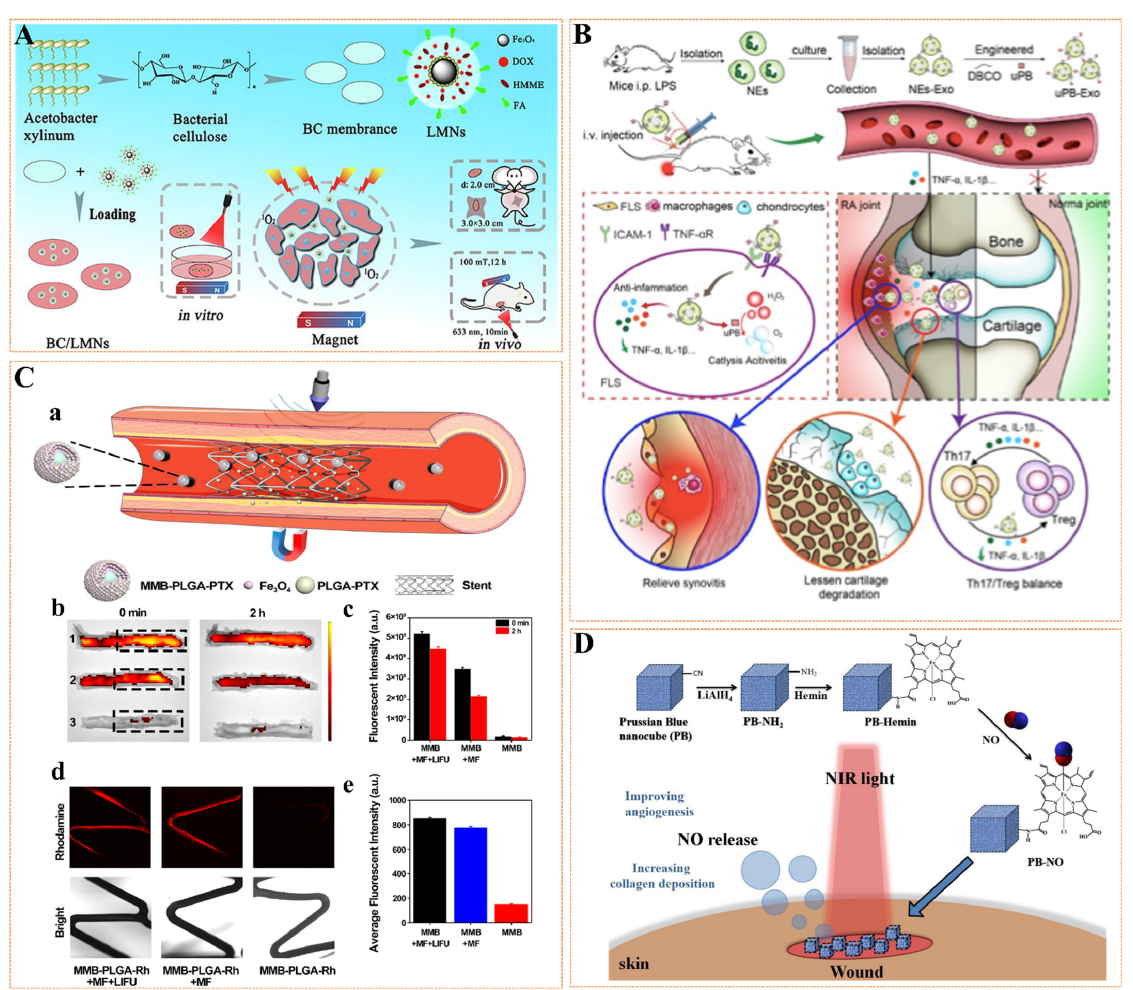
Figure 5. ( A ) The laser-sensitized magnetic nanoparticles (LMN) were constructed using Fe 3 O 4 na- noparticles as the core, coated with doxorubicin and hematoporphyrin mether hydrogel, and then coated with dendritic acid on the surface of the composite. LMN was then loaded into the bacterial cellulose (BC) membrane. Synthetic BC/LMN enhances transdermal drug targeting for breast cancer when administered via magnetic field and laser. Reprinted with permission from Ref. [109]. Copy- right 2019, copyright Zhang L.K. et al. (B) Surface-engineered neutrophil-derived exosomes (NEs- Exo) and ultra-small Prussian blue magnetic nanoparticles (uPB) effectively treat advanced rheu- matoid arthritis by clicking on the chemically mediated repair of the inflammatory environment. Reprinted with permission from Ref. [110]. Copyright 2022, copyright Zhang L. et al. ( C ) Schematic diagram of magnetic guided and ultrasonic stimulation for the treatment of ISR with targeted and deep penetrating delivery strategies ( a ); Evaluation of MMB-PLGA Rhdomain targeting and pene- tration of isolated porcine coronary arteries. ( b ) Representative fluorescence images of the stented porcine coronary arteries at 0 min and 2 h after different treatments; ( c ) Quantification of the fluo- rescence intensity in the areas within the black dotted frames at 0 min and 2 h post treatments; ( d ) Representative fluorescence and bright field images of the stents at 2 h post treatments; ( e ) Quanti- fication of the fluorescence intensity of the stents shown in the fluorescence images. Reprinted with permission from Ref. [111]. Copyright 2020, copyright Wang S. et al.(D) Preparation of NO-carried Prussian blue (PB-NO) nanocubes for the treatment of incisional wounds. Reprinted with permis- sion from Ref. [112]. Copyright 2019, copyright Su C.H. et al.